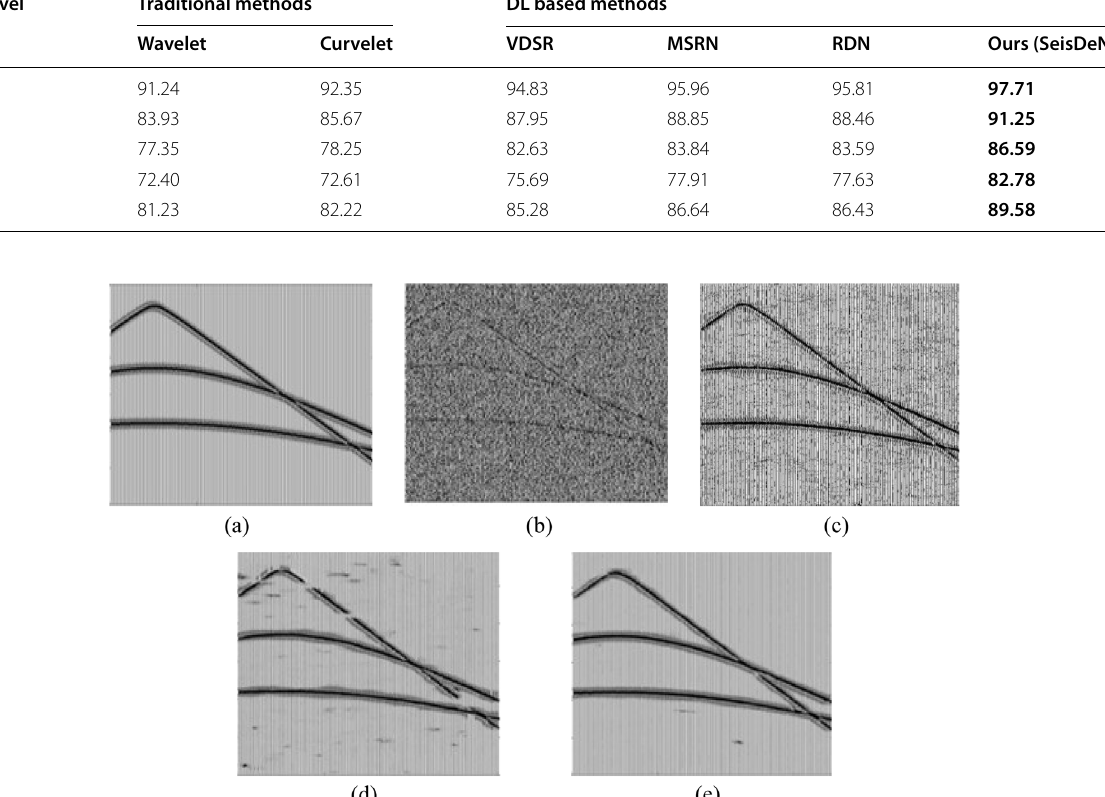
Table 2 Comparison of PSNRs for various approaches on SEG/EAGE salt and overthrust model Noise level